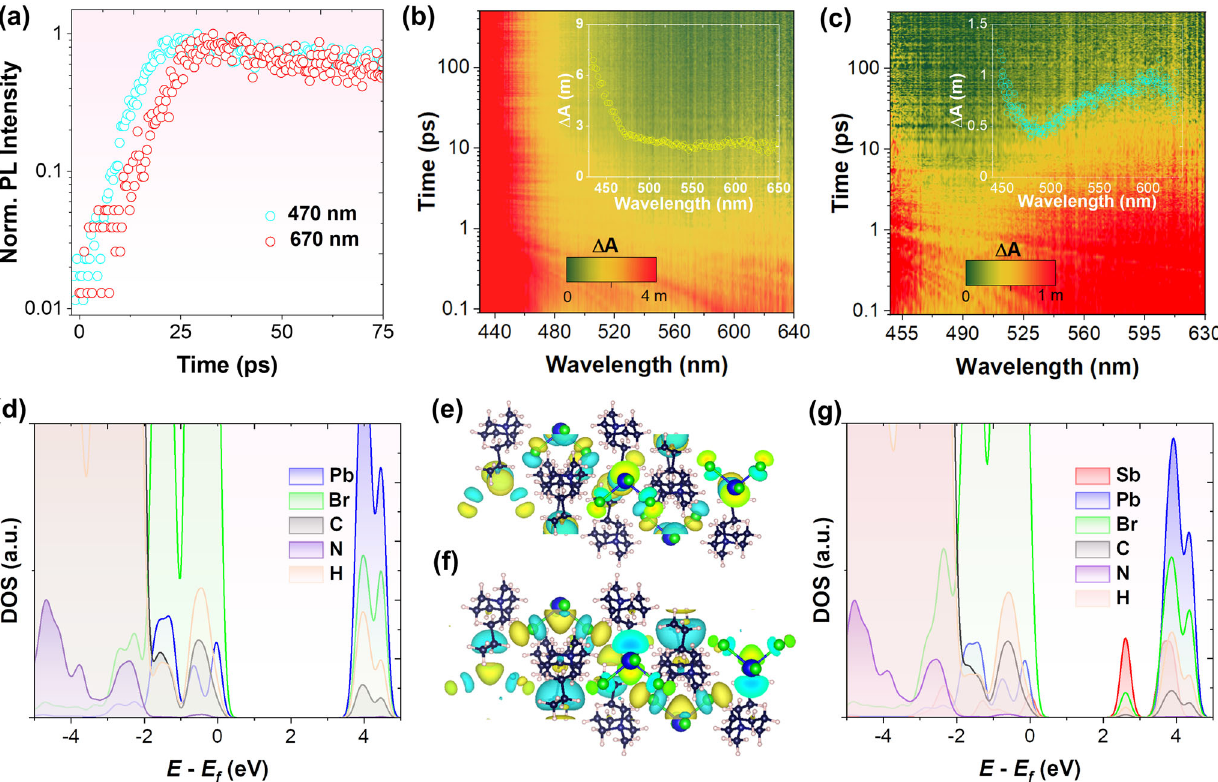
Fig. 3 Emission mechanism. a Time-resolved PL emission rise curves monitoring at two emission bands in Pb-Br: Sb. Pseudo-color fs-TA plot of Pb-Br: Sb pumping at 360 nm ( b ) and 390 nm ( c ) pulse, respectively. Inset shows the representative fs-TA spectra. Calculated atomic-orbital DOS of undoped ( d ) and Sb 3 + doped ( g ) Pb-Br. Calculated HOMO ( e ) and LUMO ( f ) for the ground states of